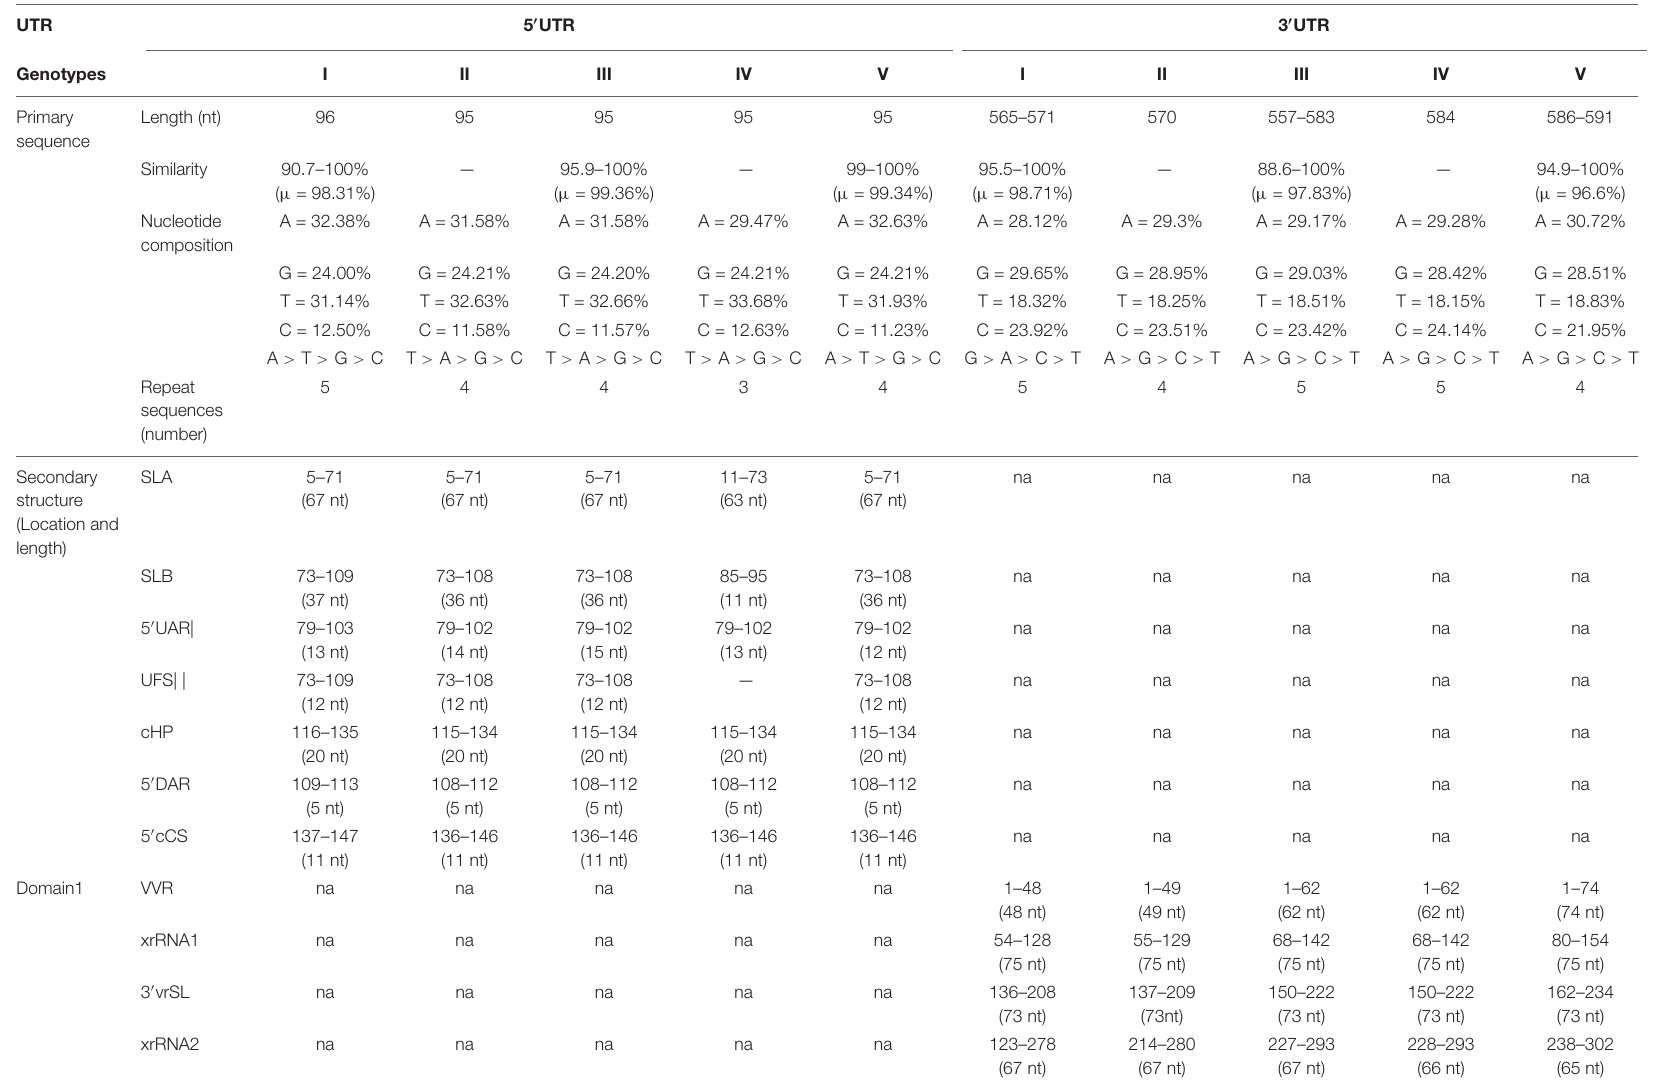
TABLE 1 | Primary sequence and secondary structure elements analysis of the JEV’s